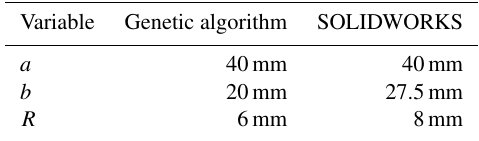
Table 3. Design variables obtained by the genetic algorithm and SOLIDWORKS